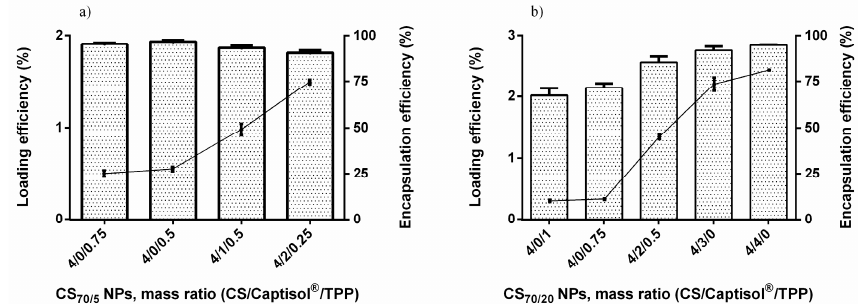
Figure 4. Encapsulation efficiency (grey column) and loading efficiency (black circle) of quercetin in selected loaded nanoparticle formulations of CS 70/5 ( a ); and CS 70/20 ( b ).